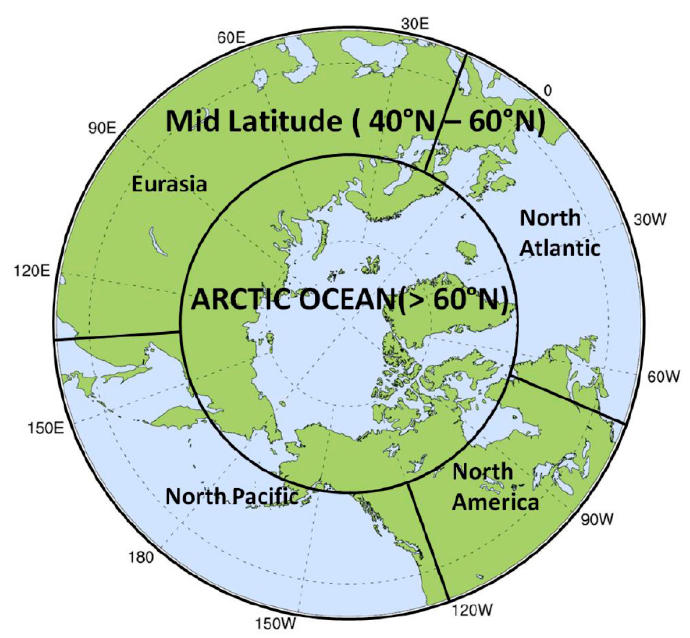
Figure 2. Storm track regions over the Northern Hemisphere—mid-latitude (40° N–60° N) and the Arctic (above 60° N). The mid-latitude region is further divided into the North Pacific (140 °E–120° W), North America (120° W–70° W), North Atlantic (70° W–20° E) and Eurasia (20° E–140° E) sub-regions.